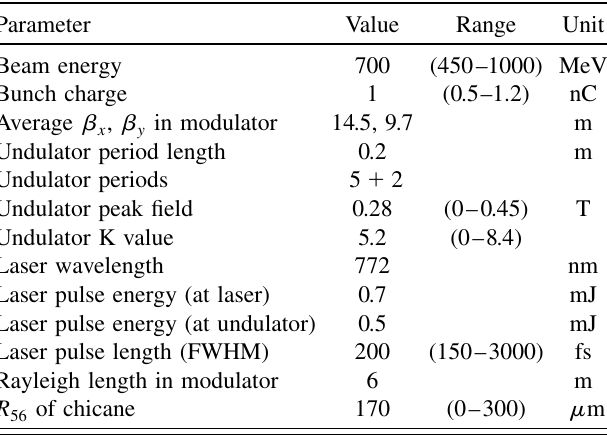
TABLE I. The parameters used during the experiments. Parameter